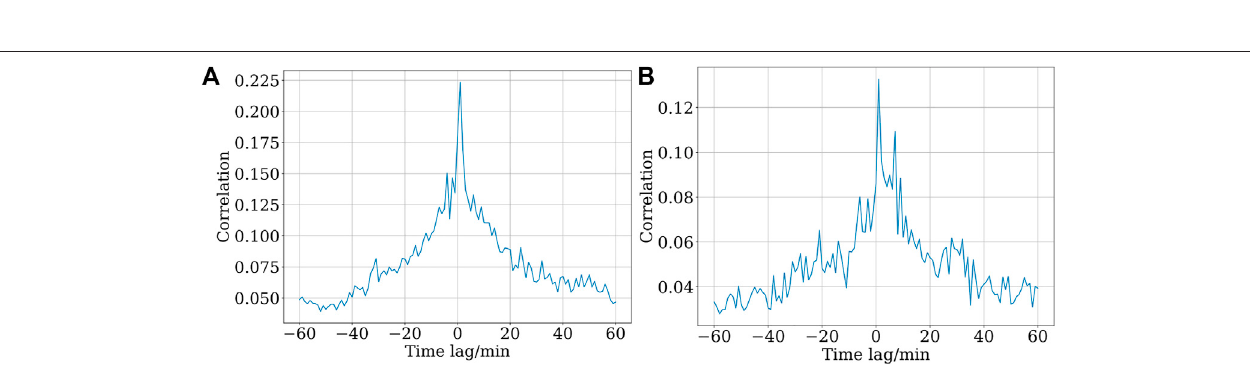
FIGURE 3 | (A) Squared volume-weighted price returns – volume correlation. All values of correlation are statistically signi fi cant ( p -value ≤ 0.001). Permutation signi fi cance check indicates no statistically signi fi cant correlation between time-permuted squared price returns and volume series. (B) Squared volume-weighted price returns – bid – ask spread correlation. All values of correlation are statistically signi fi cant ( p -value ≤ 0.001). Permutation signi fi cance check indicates no statistically signi fi cant correlation between time-permuted squared price returns and volume series.